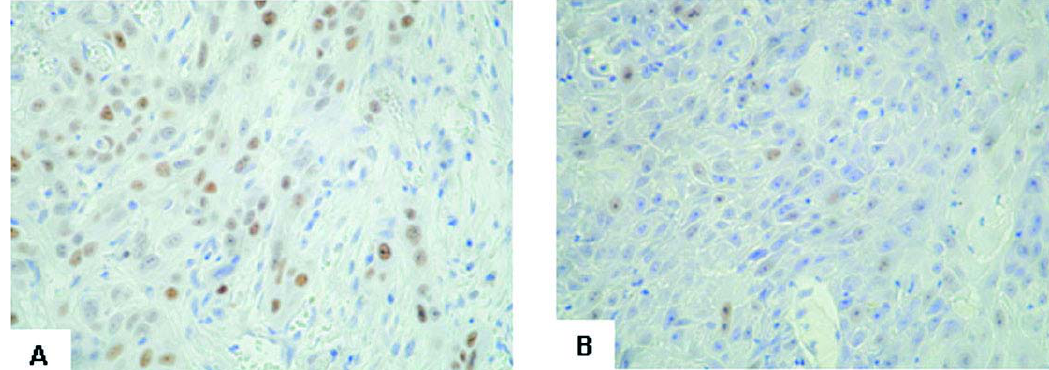
FIGURE 2- Immunohistochemical staining. A: Immunohistochemical staining for pRb in OSCC. Most tumor cells show intense nuclear staining (SABC, ×200); B: Immunohistochemical staining for p21 in OSCC. The tumor cells show weak nuclear staining (SABC,